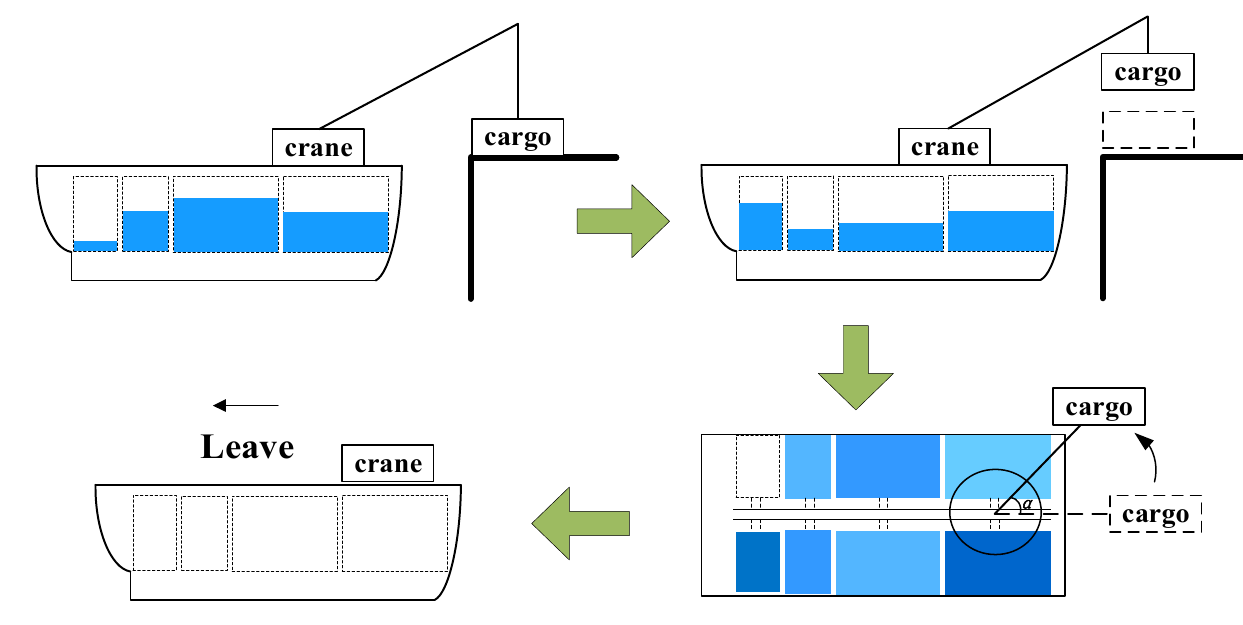
Figure 1. The lifting operation process of the RFC. α is the rotating angle of the crane.